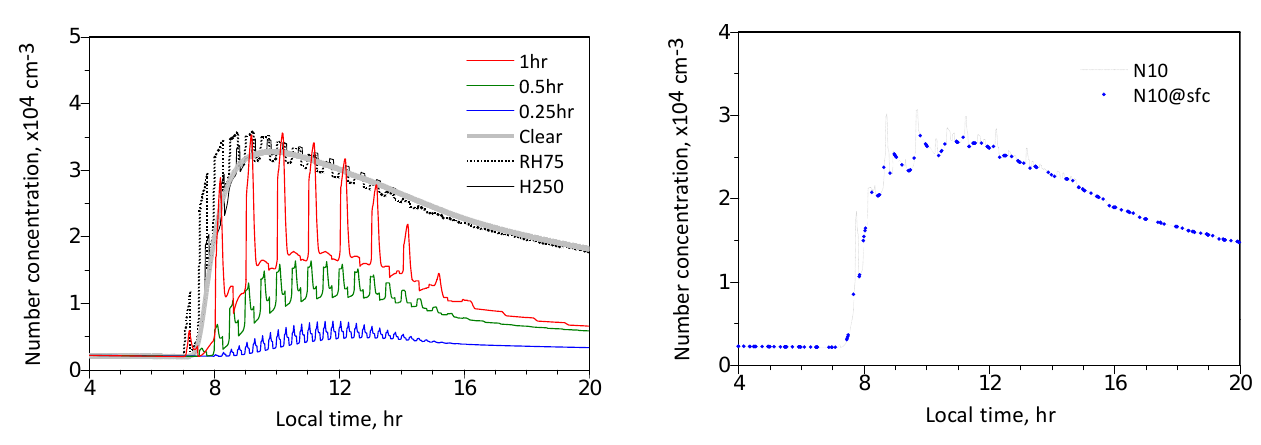
Fig. 11. Evolution of D > 10 aerosol number concentrations under various scenarios of turbulence eddy. The green curve (cycle period 0.5h) is the same as the Q = 1 curve in Fig. 7b, and is called the reference run. The thick-grey curve is the same as the Q = 1 curve in Fig. 4b, representing the clear sky situation without turbulence eddy. The red curve and the blue curve applied the same conditions as the reference run except for the cycling periods of 1h and 0.25h, respectively. The dotted curve (RH75) differs from the reference run in its lower (by 5%) initial relative humidity; while the thin- solid curve (H250) applied a vertical amplitude that is one half of the reference run (a half-height of 250m).